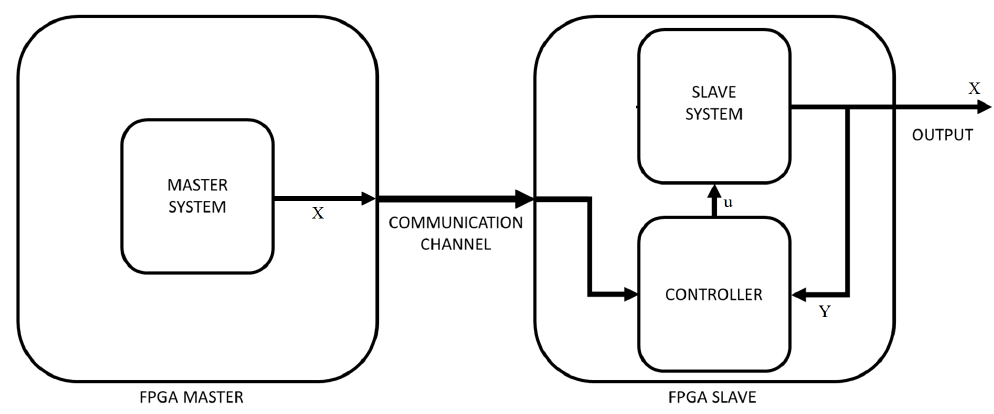
Figure 1. Synchronization scheme